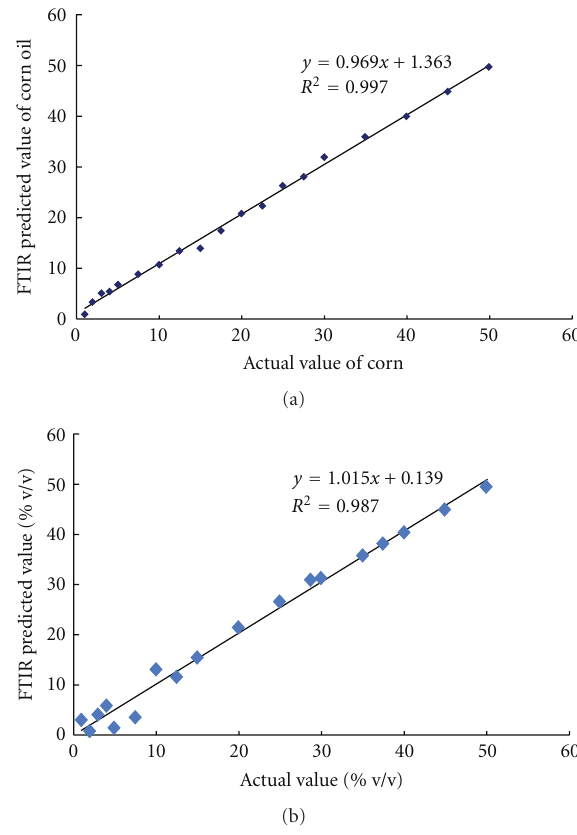
Figure 4: PLS model for relationship between actual value and FTIR predicted value of sunflower oil using FTIR 1st derivative spectra at 3025–3000 and 1400–985 cm − 1 ; (a) calibration; (b)